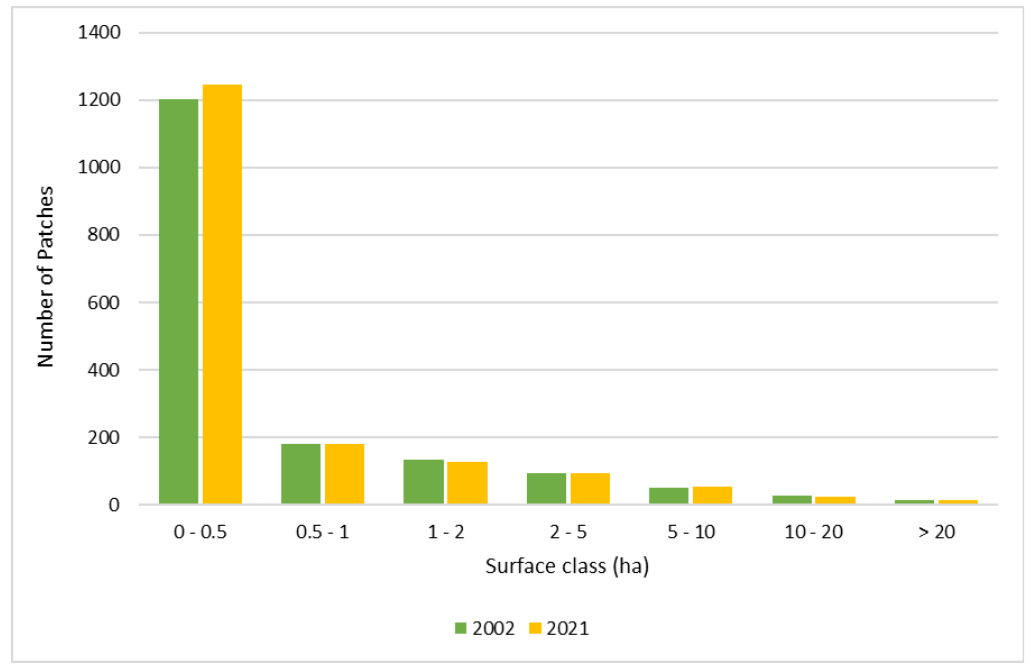
Figure 3. For both 2002 and 2021, most of the identified igune and small woods have a surface smaller than 1 ha.